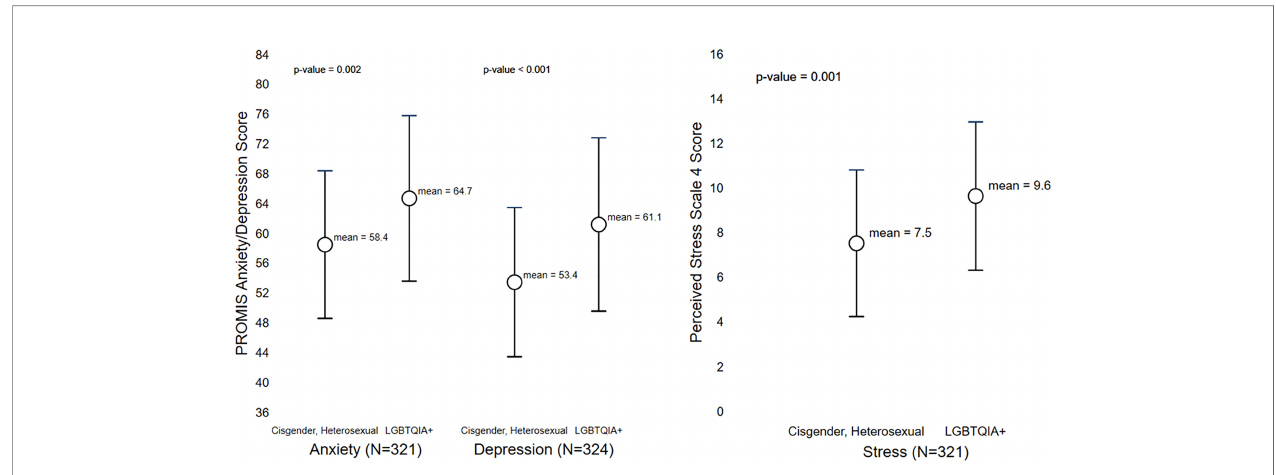
FIGURE 4 | Differences in Mental Health Outcomes Between Cisgender, Heterosexual and LGBTQIA+ AYA Cancer Survivors.